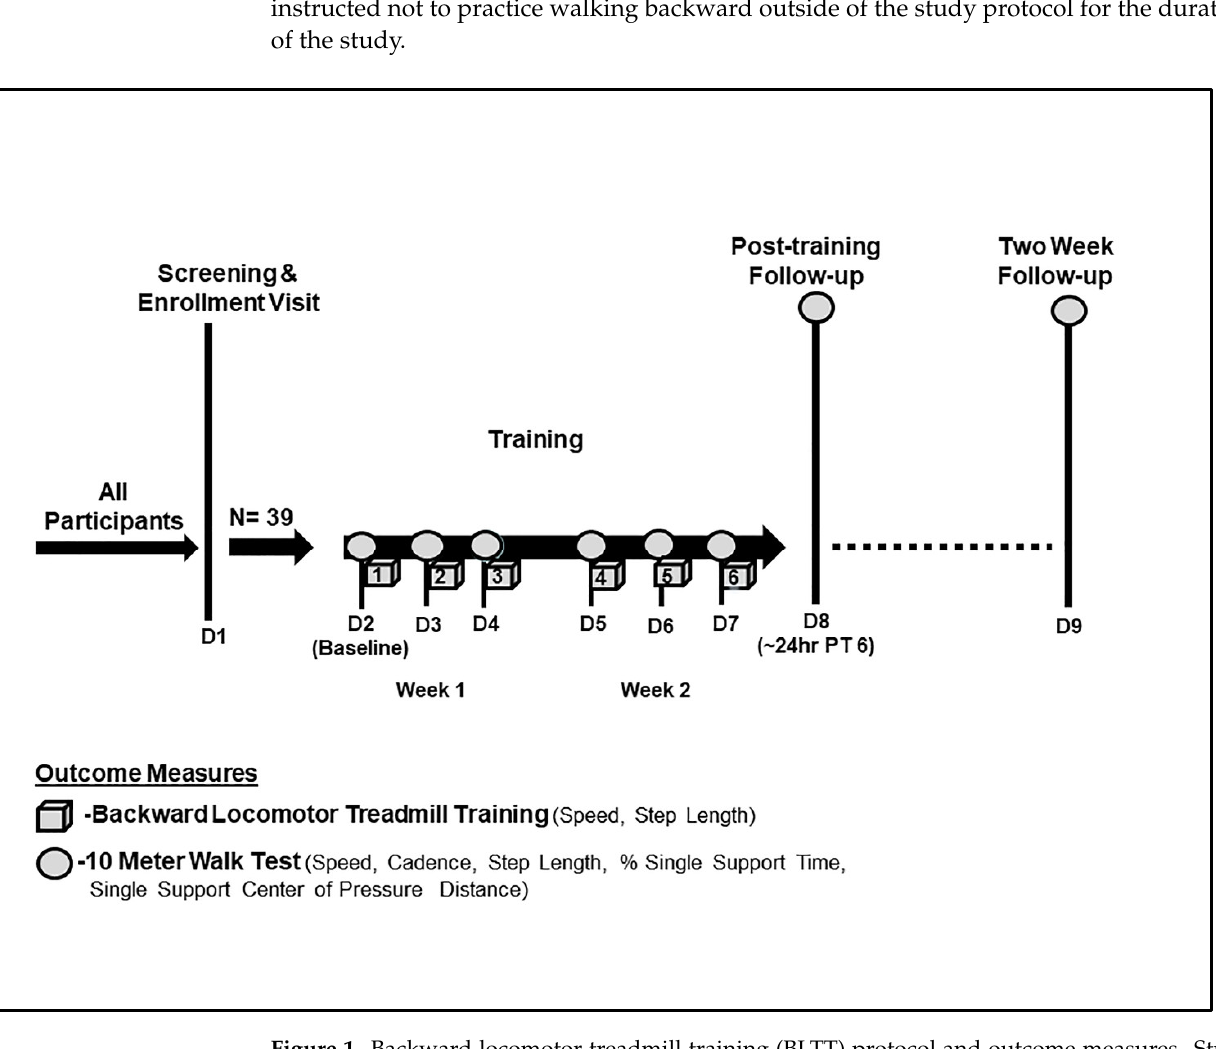
Figure 1. Backward locomotor treadmill training (BLTT) protocol and outcome measures. Study participants underwent six 30-min sessions of BLTT over 2 weeks (cube). The BLTT-related outcome measures were obtained during the six sessions of training (D2–D7). In contrast, outcome measures related to overground walking performance were obtained prior to each training session (baseline (D2), subsequent training days (D3–D7)), ~24 h following the completion of the sixth training day (D8), and at 2-week